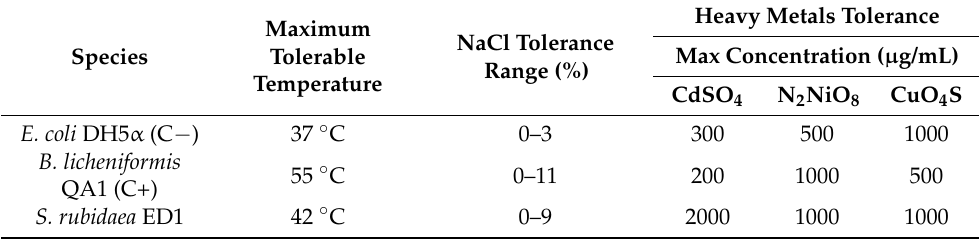
Table 2. Summary of relevant extreme properties of isolated endophytic bacterium Serratia rubidaea